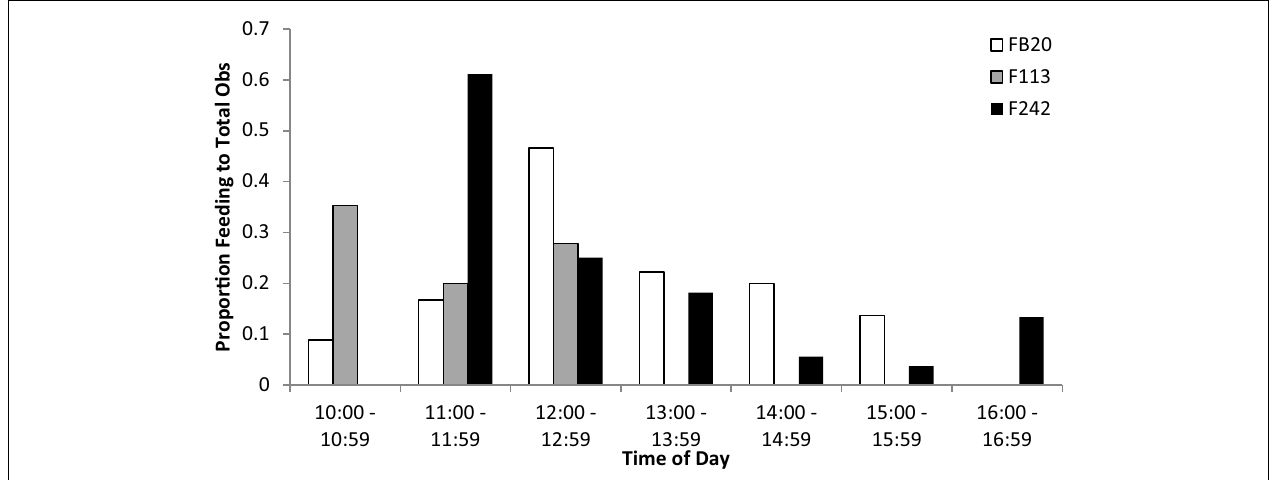
FIGURE 5 | Occurrence of day-time feeding observations for Sarasota Bay bottlenose dolphins tagged with satellite-linked transmitters in 2012 . Bars indicate the proportion of total focal animal behavioral observations that involved feeding or probable feeding, relative to time of day. Note that no observations of any kind were obtained for dolphin F113 during